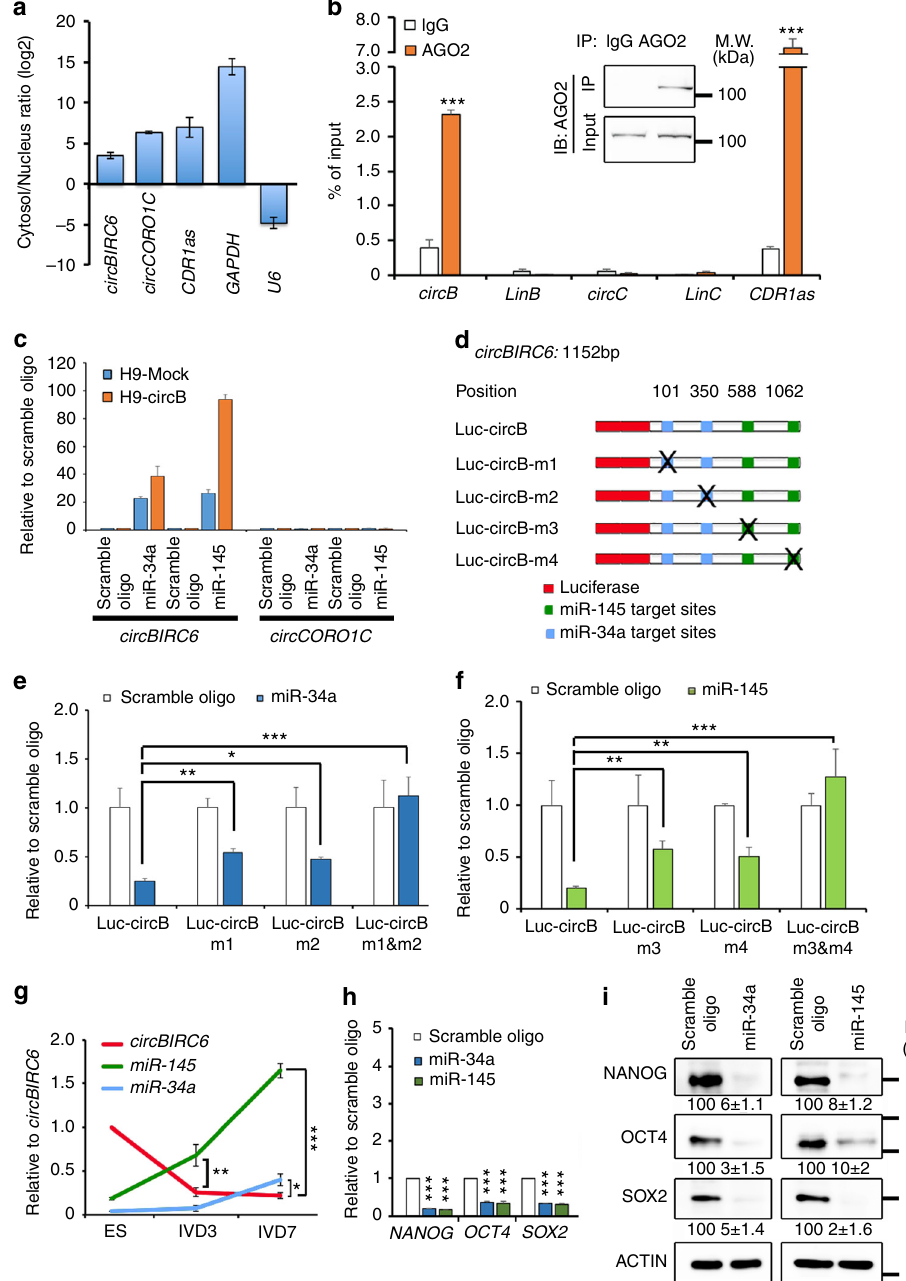
Fig. 5 CircBIRC6 interacts with and sequester miR-34a and miR-145. a RT-qPCR analysis of cytoplasmic-to-nuclear expression ratios of circBIRC6 , circCORO1C , CDR1as , GAPDH , and U6 in hESCs. b RIP analysis of circBIRC6 , linear BIRC6 (linB) , circCORO1C , linear CORO1C (LinC) , and CDR1as in hESCs using antibodies against AGO2. Immunoblotting (IB) of immunoprecipitated (IP) AGO2 protein is shown. The RIP enrichment of the AGO2-associated circular RNAs (as indicated) was measured by RT-qPCR, and each value was normalized to the level of input RNA used in RIP analysis. c RT-qPCR analysis of circBIRC6 or circCORO1C pulled-down by biotinylated miR-34a or miR-145 mimics in hESCs. d Schematic illustration showing the 3 ′ UTR of luciferase reporters containing the complete circBIRC6 sequence (luc-circB) or circBIRC6 sequence with deletions of miR-34a (luc-circBm1 and luc-circBm2) or miR-145 (luc-circBm3 and luc-circBm4) binding sites. e , f Reporter assays showing the luciferase activity of luc-circB and luc-circBm1-m4 in 293T cells co-transfected with e miR-34a or f miR-145 mimics, or a scrambled oligonucleotide (control). g RT-qPCR analysis of circBIRC6 , miR-34a , and miR-145 expression during hESC differentiation. IVD: in vitro differentiation day. h RT-qPCR and i immunoblot analyses of the indicated gene and protein expression in hESCs transfected with miR-34a or miR-145 mimics, or scrambled oligonucleotide 3 days post transfection. Protein level quanti fi cation was normalized to actin and shown below each panel. Quantitative data from three independent experiments is presented as mean ± SD (error bars). P -values were determined by two-tailed two-sample t -tests (* P < 0.05; ** P < 0.01; *** P <